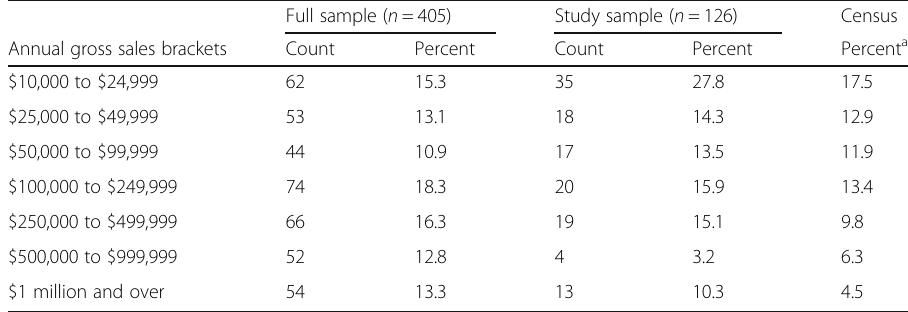
Table 1 Gross sales of survey respondents in full and study sample compared to census Full sample ( n = 405) Study sample ( n =